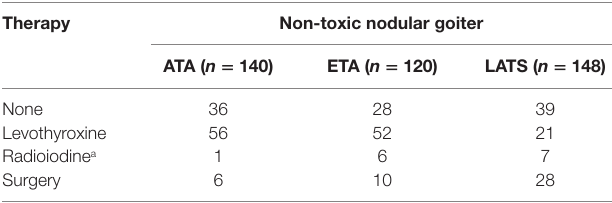
TABLe 1 | Treatment choices reported by ATA, eTA, and LATS members based on an index case of a patient with a simple non-toxic nodular goiter, without suspicion of